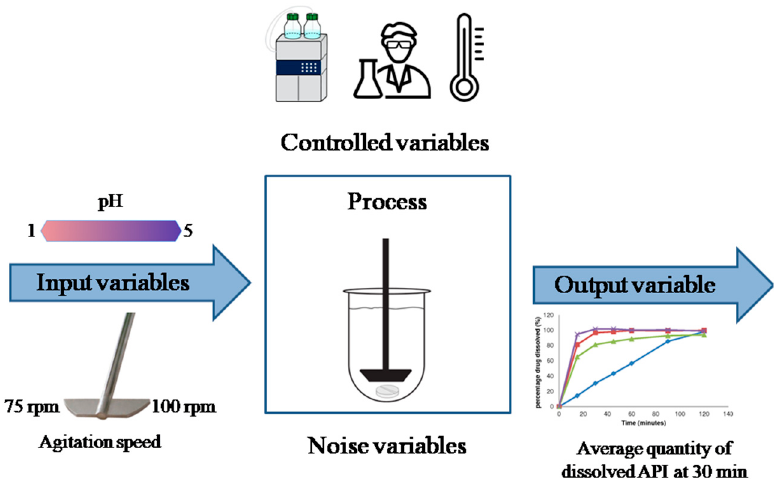
Figure 2. Example of an Ishikawa diagram for risk management in Formulation Development car- ried out in the Academy. Reprinted with permission from Castillo, L. et al. Drug Development and Industrial Pharmacy , 45(10). Copyright (2019) Taylor & Francis [44].